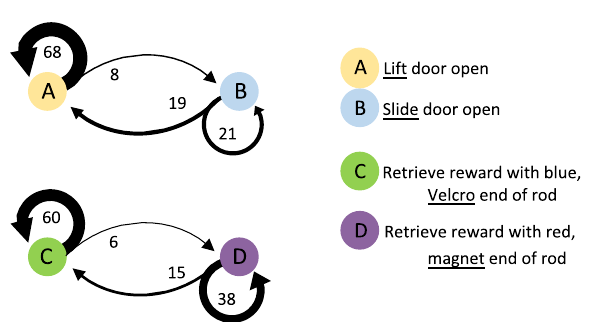
Fig. 5 The fate of actions, illustrating emulation. For each of the four causally relevant actions in participants ’ input, arrows show the extent to which participants imitated, and therefore retained them in their output (arrow to itself) or emulated, and therefore performed the alternative action (see Table 1) for the same function (arrow to the other action). E.g., of the 40 participants who saw or heard action ‘ slide the door open ’ (action B), 21 retained it in their output and 19 emulated and ‘ lifted the door open ’ instead (Action A). See also SM.3 for the fate of all action